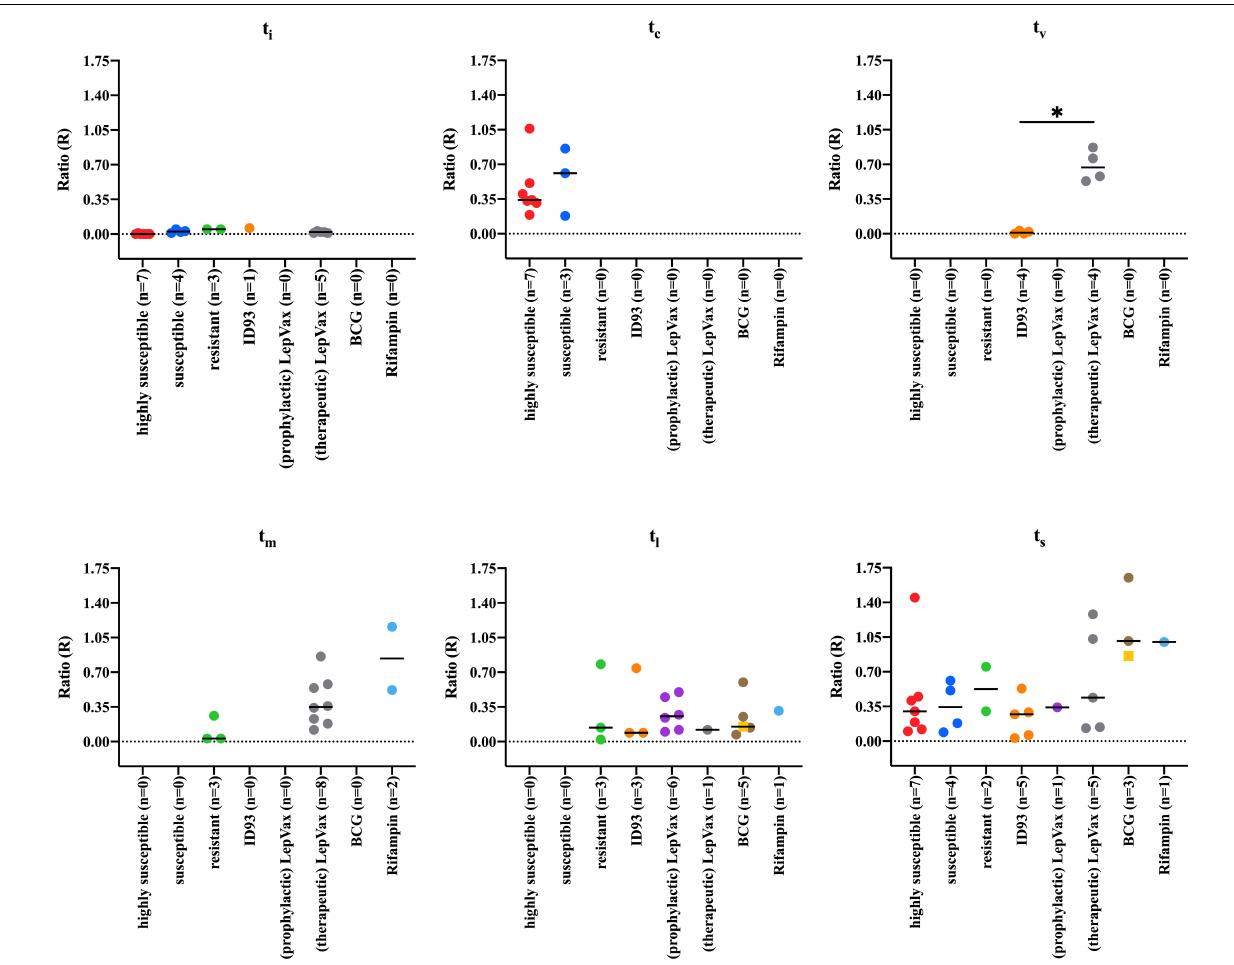
FIGURE 7 | Anti-PGL-I IgM levels by UCP-LFA in M. leprae infected armadillos after interventions. Anti-PGL-I IgM levels were measured by UCP-LFA in serum from M. leprae [1 × 10 9 bacilli; NHDP 63 ( n = 33), NHDP 98 ( n = 7), or Brazil 4923 ( n = 11)], and one animal was infected in the wild) infected armadillos ( n = 17) divided into highly susceptible ( n = 7, red dots), susceptible ( n = 4, blue dots), and resistant ( n = 6, green dots). 24 armadillos were prophylactically vaccinated with ID93 ( n = 9, orange) or LepVax ( n = 7, purple dots) 1 month post-infection; eight armadillos were therapeutically vaccinated LepVax (gray dots) 10–32 months post-infection; Eight armadillos were vaccinated with BCG 1 month pre- ( n = 6, brown dots) or post- ( n = 2, yellow squares) infection. Rifampin was provided for 3 months to armadillos ( n = 3, teal dots) 8 or 10 months post-infection. UCP-LFA results are displayed as the Ratio value (R) between Test (T) and Flow-Control (FC) signal ( y-axis ). The median values of each group are indicated by horizontal lines. Differences between groups were determined by Kruskal-Wallis test with Dunn’s correction for multiple testing. P -values: ∗ p < 0.05. t i , time of inoculation; t c , time of seroconversion (for highly susceptible and susceptible animals); t v , time of vaccination; t m , mid-stage disease; t l , late-stage disease; t s , time at